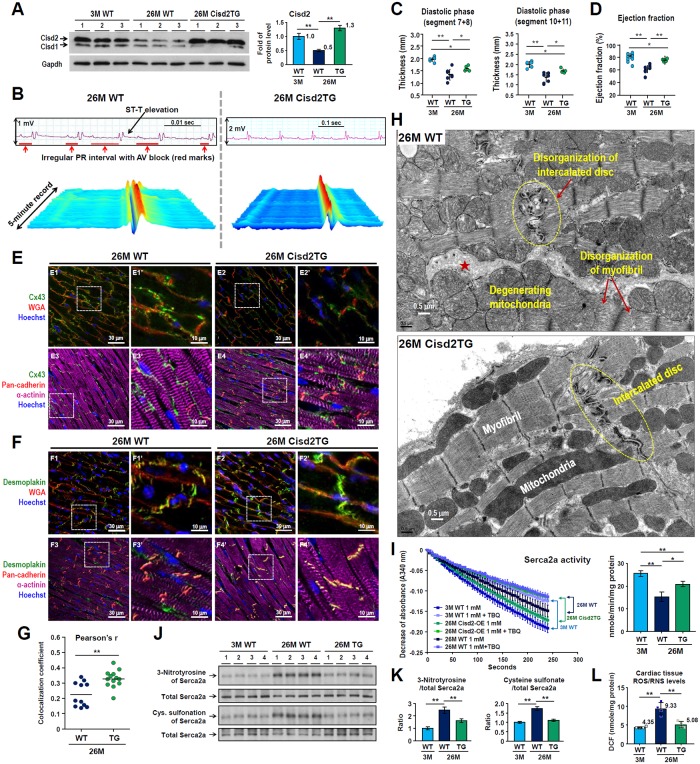
A high level of Cisd2 delays cardiac aging and attenuates age-related structural defects and functional decline during old age.(A) Western blot analysis revealed that Cisd2 protein is about 2.6-fold higher in the cardiac muscle of 26M Cisd2TG mice compared with 26M WT mice. (B) Representative waterfall plots and ECG tracings recorded following anesthesia of mice. Abnormal ECG, namely ST-T elevation and irregular PR interval, were recorded from 26M WT mice. However, relatively normal sinus rhythm of the ECG was recorded from the 26M Cisd2TG mice. (C and D) Analysis of the MRI of diastolic segment 7+8 (anterior LV free wall, C) and diastolic segment 10+11 (interventricular LV wall, D). Data are presented as mean ± SD. Mouse number n = 5–6 for each group. (E and F) A high level of Cisd2 alleviates age-related damage to the intercalated discs. Lateralization of gap junctions revealed by Cx43 staining (E) and maldistribution of desmosomes revealed by desmoplakin staining (F) were easily found in the 26M WT mice. However, these defects are barely detectable in the 26M Cisd2TG mice. Method of IF imaging is the same as in Fig 3A and 3E. (G) Colocalization coefficient of gap junctions (Cx43) and intercalated discs (pan-cadherin) was analyzed using Pearson’s correlation. Method is the same as in Fig 3B. (H) A high level of Cisd2 preserves the integrity of cardiac ultrastructure in the Cisd2TG mice at old age. TEM analysis revealed ultrastructural defects in the cardiac muscle of aged WT mice at 26M. The age-related defects include disorganization of intercalated disc; expanded intercellular space (★), which might be caused by breakdown of the intercalated disc; mitochondrial degeneration (e.g., mitochondria with discontinuous or ruptured outer and inner membranes, swollen mitochondria with fewer crista); and disorganization of myofibrils with partial disruption of Z bands and fewer myofilaments. In the Cisd2TG mice, the integrity of mitochondria and intercalated disc, as well as the alignment of myofibrils, is well preserved in the cardiac muscle. (I) Serca2a activity was measured using an enzyme-coupled spectrophotometric assay (n = 3–4). Method is the same as in Fig 4N. (J and K) Western blot analysis (J) and quantification (K) of oxidative modifications to Serca2a by 3-nitrotyrosine and cysteine sulfonation using heart tissues (n = 4). (L) Quantification of ROS and RNS levels in heart by measuring DCF levels using cardiac tissues (n = 4 for each group). The data are presented as mean ± SD and are analyzed by Student t test. *p < 0.05; **p < 0.005. Values for each data point can be found in S1 Data. 3M, 3 months old; 26M, 26 months old; AV, atrioventricular; Cisd2, CDGSH iron-sulfur domain-containing protein 2; Cx43, Connexin 43; DCF, 2′, 7′-dichlorofluorescein; ECG, electrocardiography; Gapdh, glyceraldehyde 3-phosphate dehydrogenase; IF, immunofluorescence; LV, left ventricle; MRI, magnetic resonance image; RNS, reactive nitrogen species; ROS, reactive oxygen species; Serca2a, sarco/endoplasmic reticulum Ca2+-ATPase; TBQ, 2,5-Di-tert-butylhydroquinone; TEM, transmission electron microscopy; TG, transgenic; WGA, wheat germ agglutinin; WT, wild type.